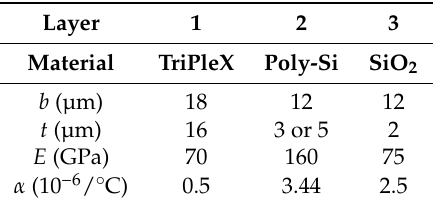
Figure B1. The cross-sectional dimensions of the three layers representing a bimorph beam. Table B1. The values of the trilayer